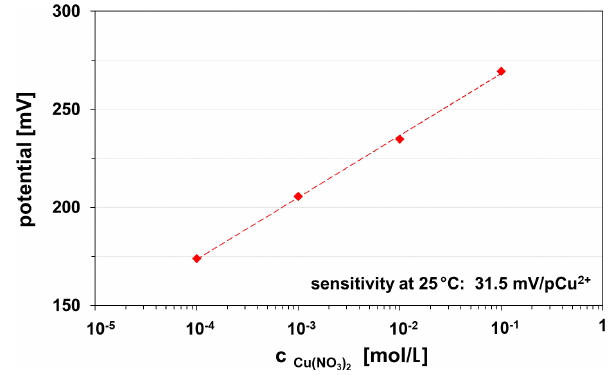
Figure 9. Calibration curve of a LTCC-based pH sensor.